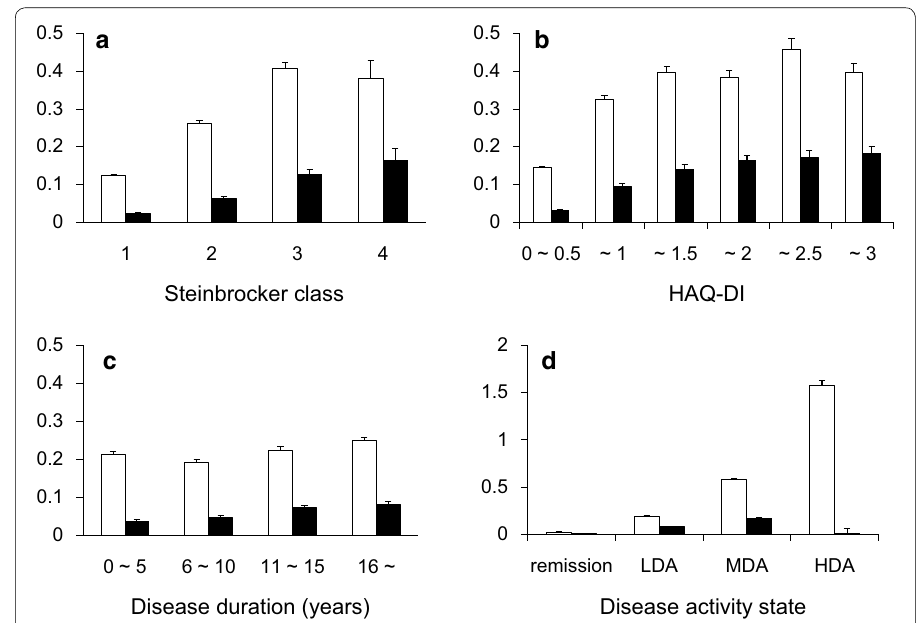
Fig. 3 Relationship between joint index vector and various measures of rheumatoid arthritis. The mean values of |Vxy| (open bar) and z (solid bar) stratified by a Steinbrocker class, b the disability index of the Health Assessment Questionnaire (HAQ-DI), c disease duration, and d disease activity state defined by Simplified Disease Activity Index (SDAI) as remission ( 3.3), low disease activity (LDA, 11), moderate disease activity ≤ ≤ (MDA, 26), and high disease activity (HDA, > 26). Error-bar indicates standard error of the mean ≤